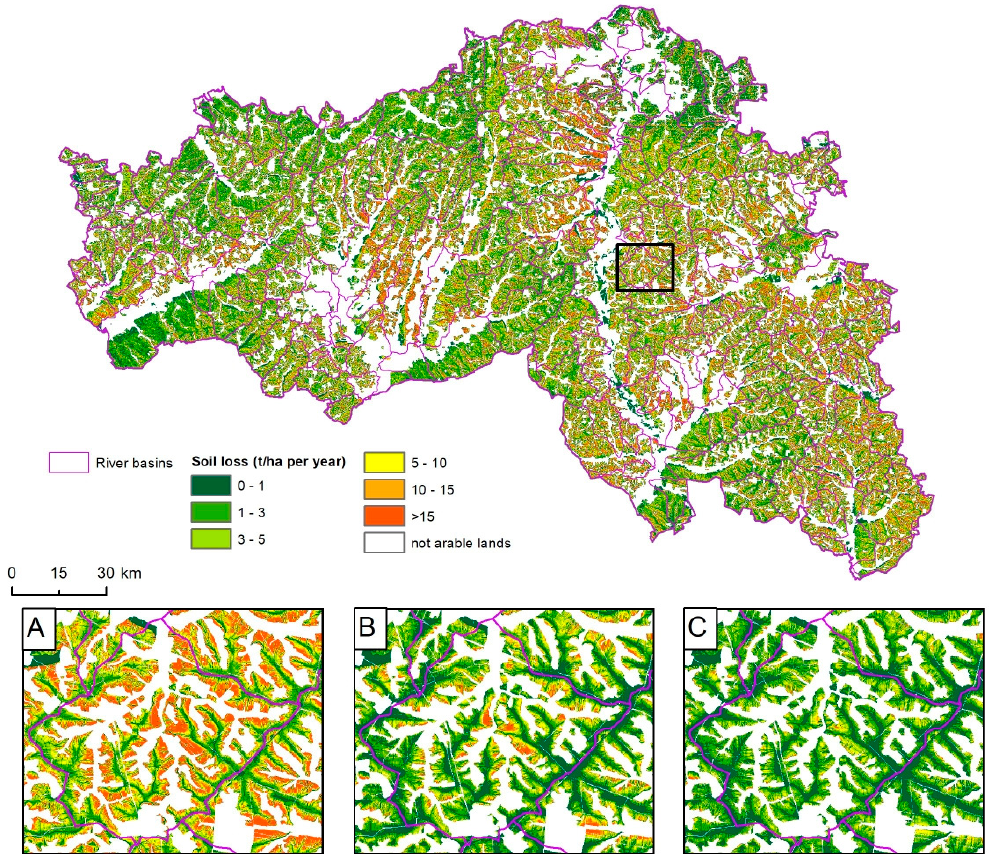
Figure 4. Potential erosion-induced soil losses on cropland in Belgorod Oblast: ( A )—for bare (clean) fallow conditions, ( B )—for actual crop composition, ( C )—for ALAS projects. NB: The map of the upper panel characterizes the erosion-induced soil losses for bare fallow conditions. Table 2. Eroded soils areas in Belgorod Oblast, according to different land-use models.